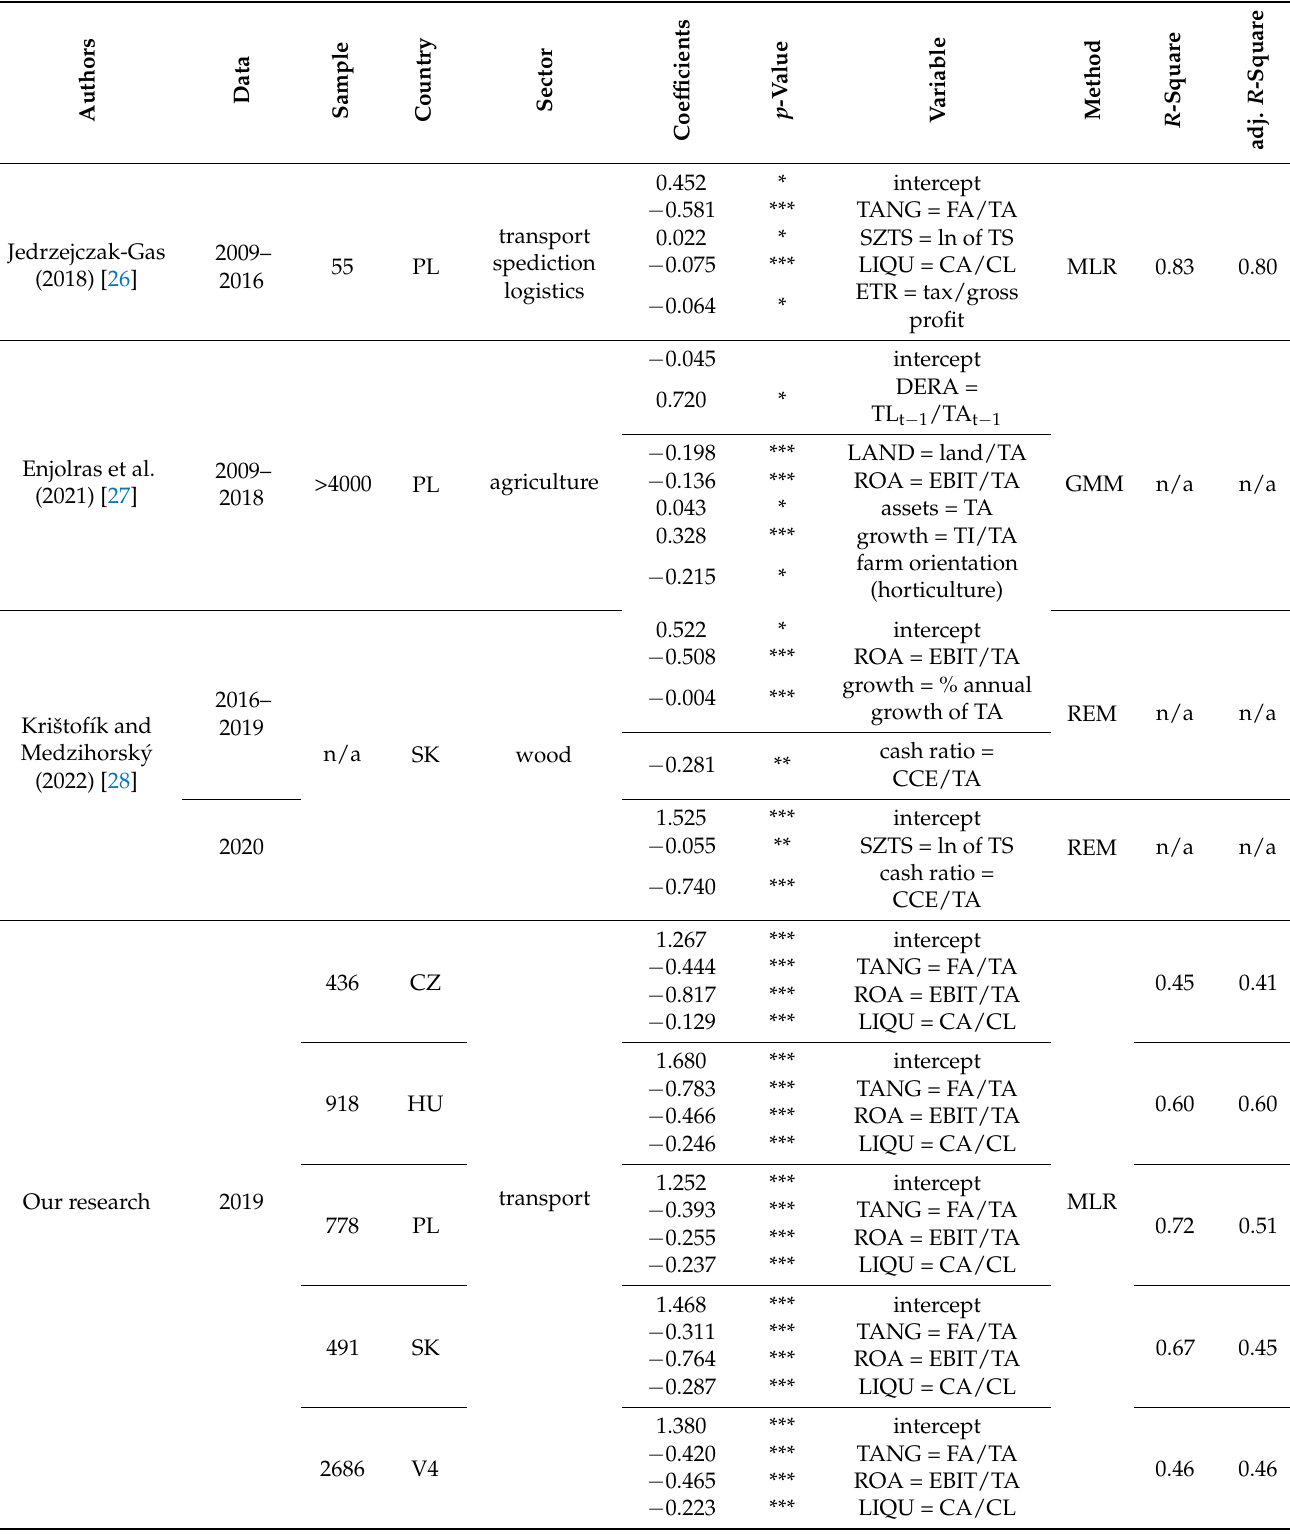
Table 9. The comparison of our research with previous